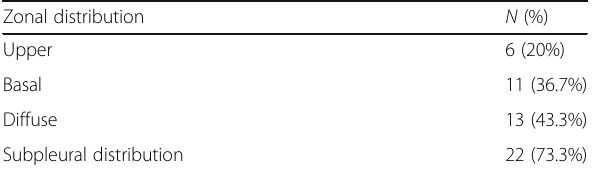
Table 4 Zonal distributions of the lung lesions